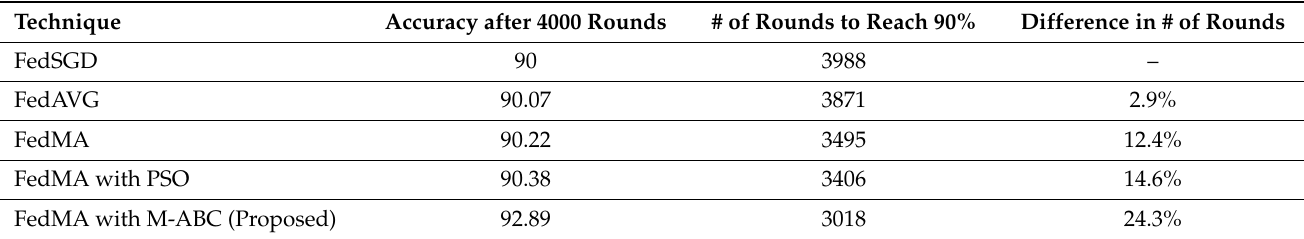
Table 4. Time to reach the accuracy of model.